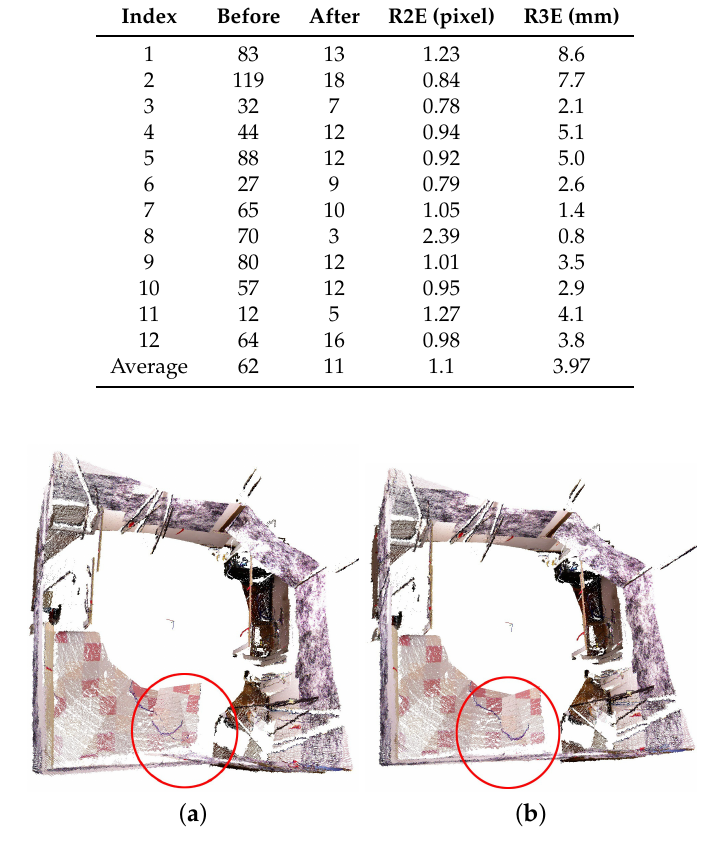
Figure 6. The aligned point clouds before ( a ) and after ( b ) closing the loop. A misalignment can be observed in the red circle on the bottom of ( a ). After pose graph optimization with loop closure, the misalignment is resolved.